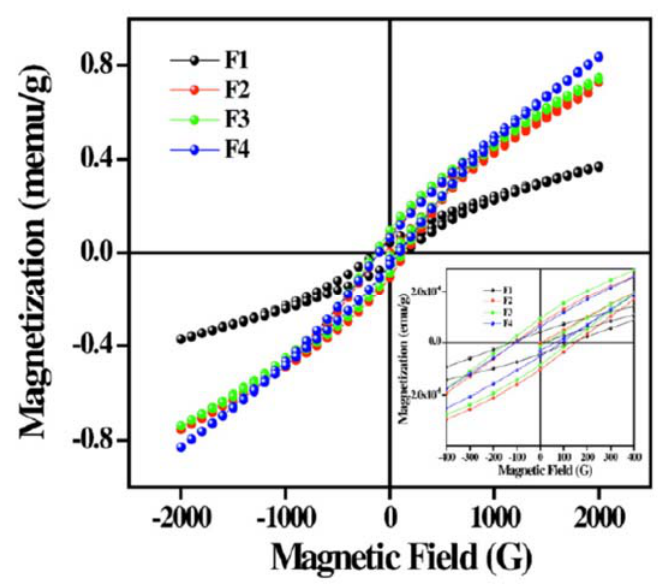
Figure 12. M-H curve of Fe doped ZnO (2, 4, 6, 8% F1–F4). Inset shows the M-H curve range − 400 to 400 G (The Figure was reproduced with copyright permission from reference [92]).